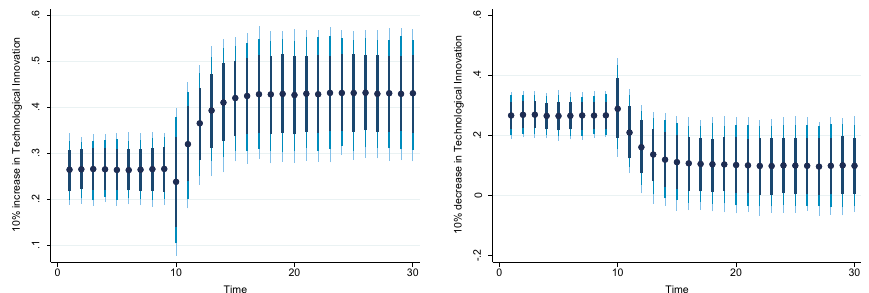
Fig. 7 The Impulse Response Plot for technological innovation and CO 2 emissions. This figure shows a 10% increase and a decrease in technological innovation and its influence on CO 2 emissions where dots specify average prediction value. However, the dark blue to light blue line denotes 75, 90, and 95% confidence interval, respectively